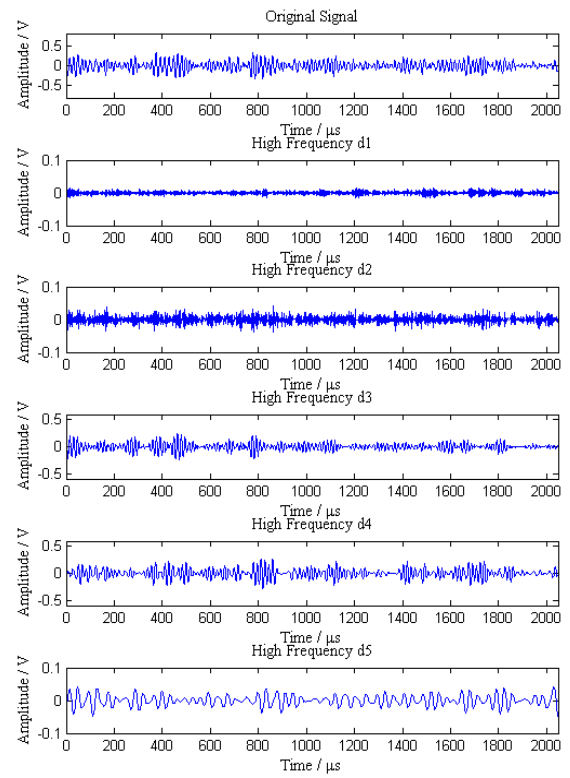
Figure 7. Signal decomposition of node 1.